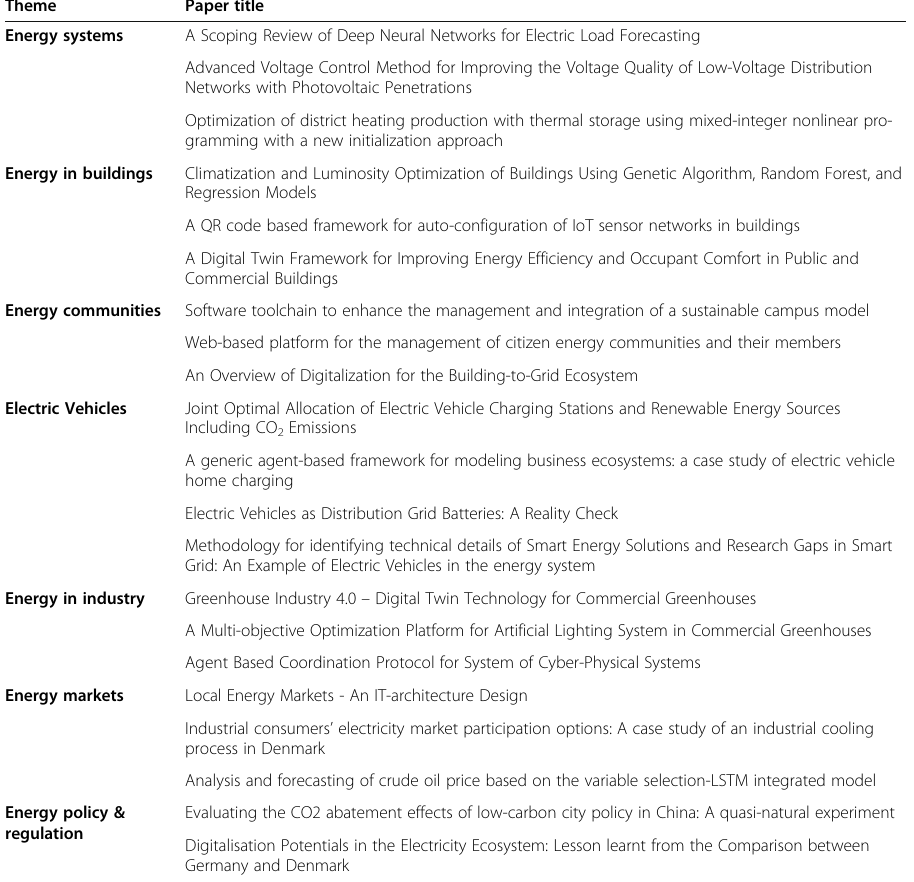
Table 1 Themes of the 21 full papers from Energy Informatics. Academy (EI.A) Asia 2021 conference